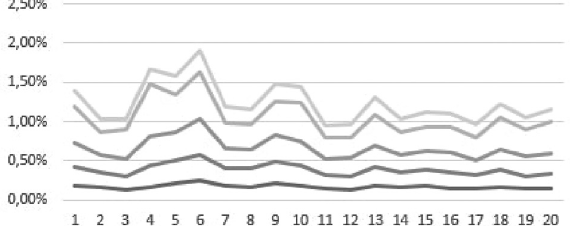
Figure 3. Top-N test terms for analysis, with the lighter shade indicating the lowest value ( N = 5) and the darker shade indicating the highest value ( N =